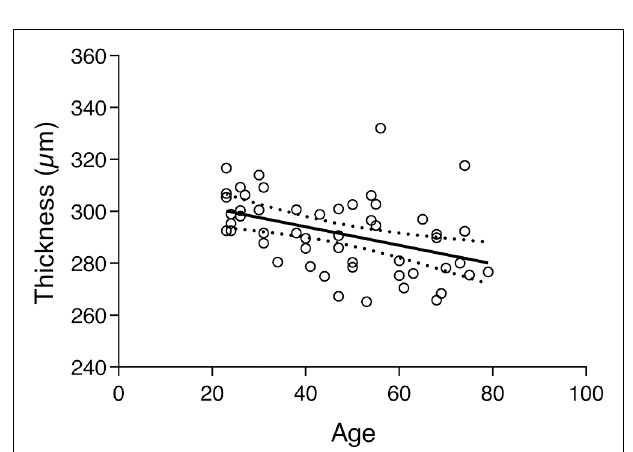
FIGURE 4 | Regression plot of the total retinal thickness vs. age and 95% confidence of the regression slop ( Y = − 0.3566 × X + 308.3; r = − 0.4186; p <